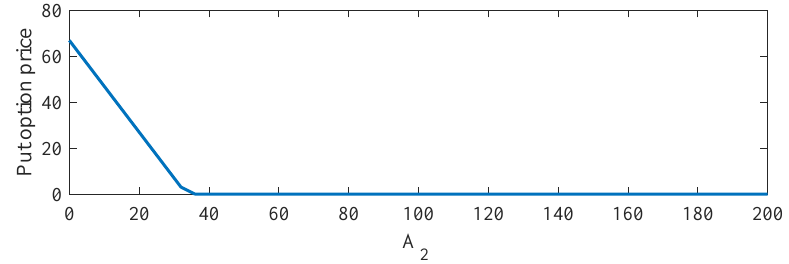
Figure 3. The solution plots of the European put option obtained from Black–Scholes model with two stock prices for A 1 = 8.